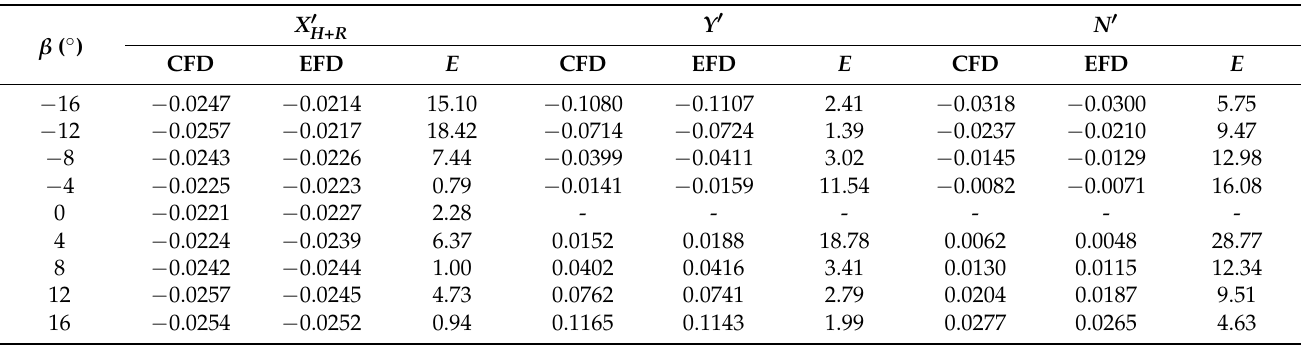
Table 11. The error between the CFD computed results and EFD data for water–air flow simulation, Fr = 0.156.